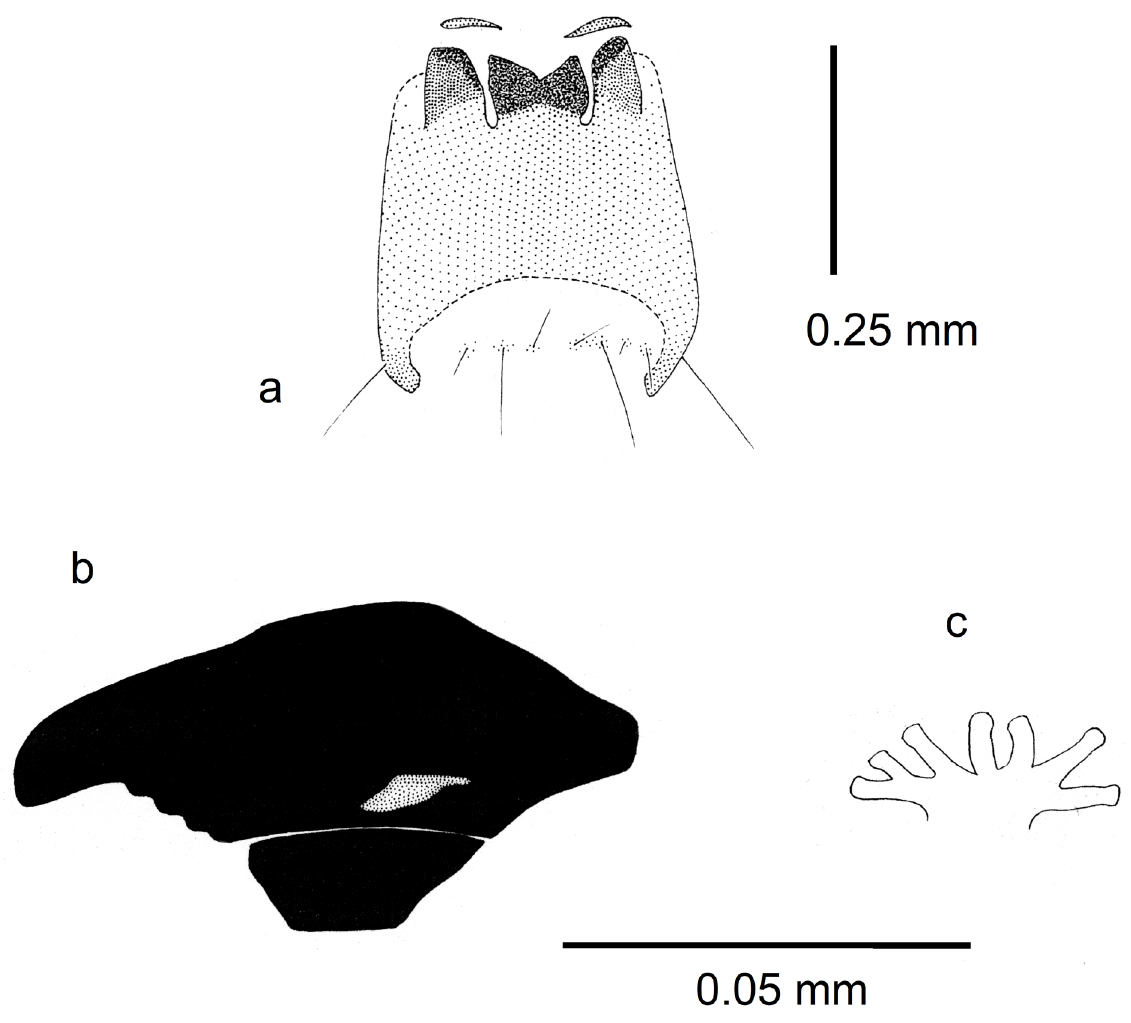
Fig. 3. a . Atherigona subnigripes (Karsch, 1888), holotype, ♀ (MNB), eighth tergite, dorsal. b–c . Atherigona varia (Meigen, 1826). b . Larval mandibular sclerite, lateral. c . Anterior spiracle of